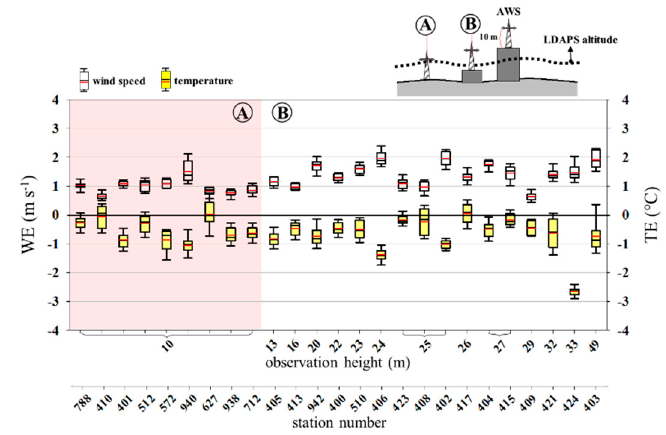
Figure 4. Box plots of the WEs and TEs at the Uf AWSs. The x -axis represents observation height of the AWSs. Left panel shaded in pink ( ○ A ) is for the AWSs installed on the ground (that is, the observation height is 10 m above ground level). Right panel shaded in blue is for the AWSs installed on building roofs ( ○ B ).